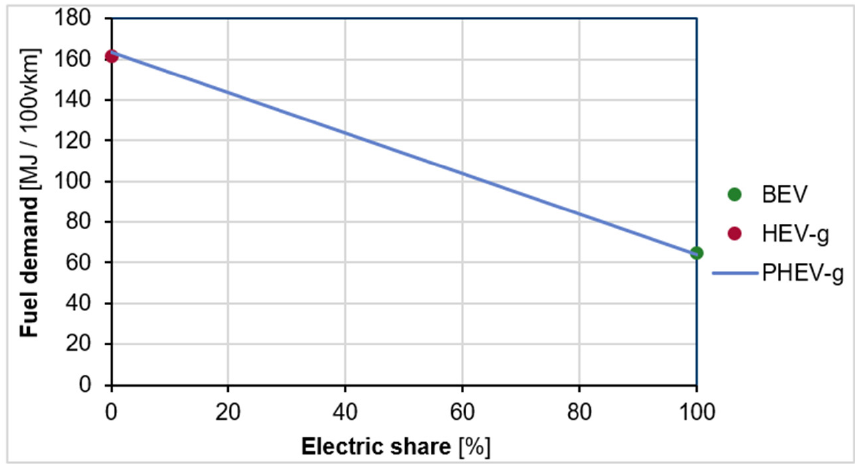
Figure 15. Fuel energy demand vs. electric share for a medium car. The assumption here is that the electric share is only influenced by the driver’s behavior.